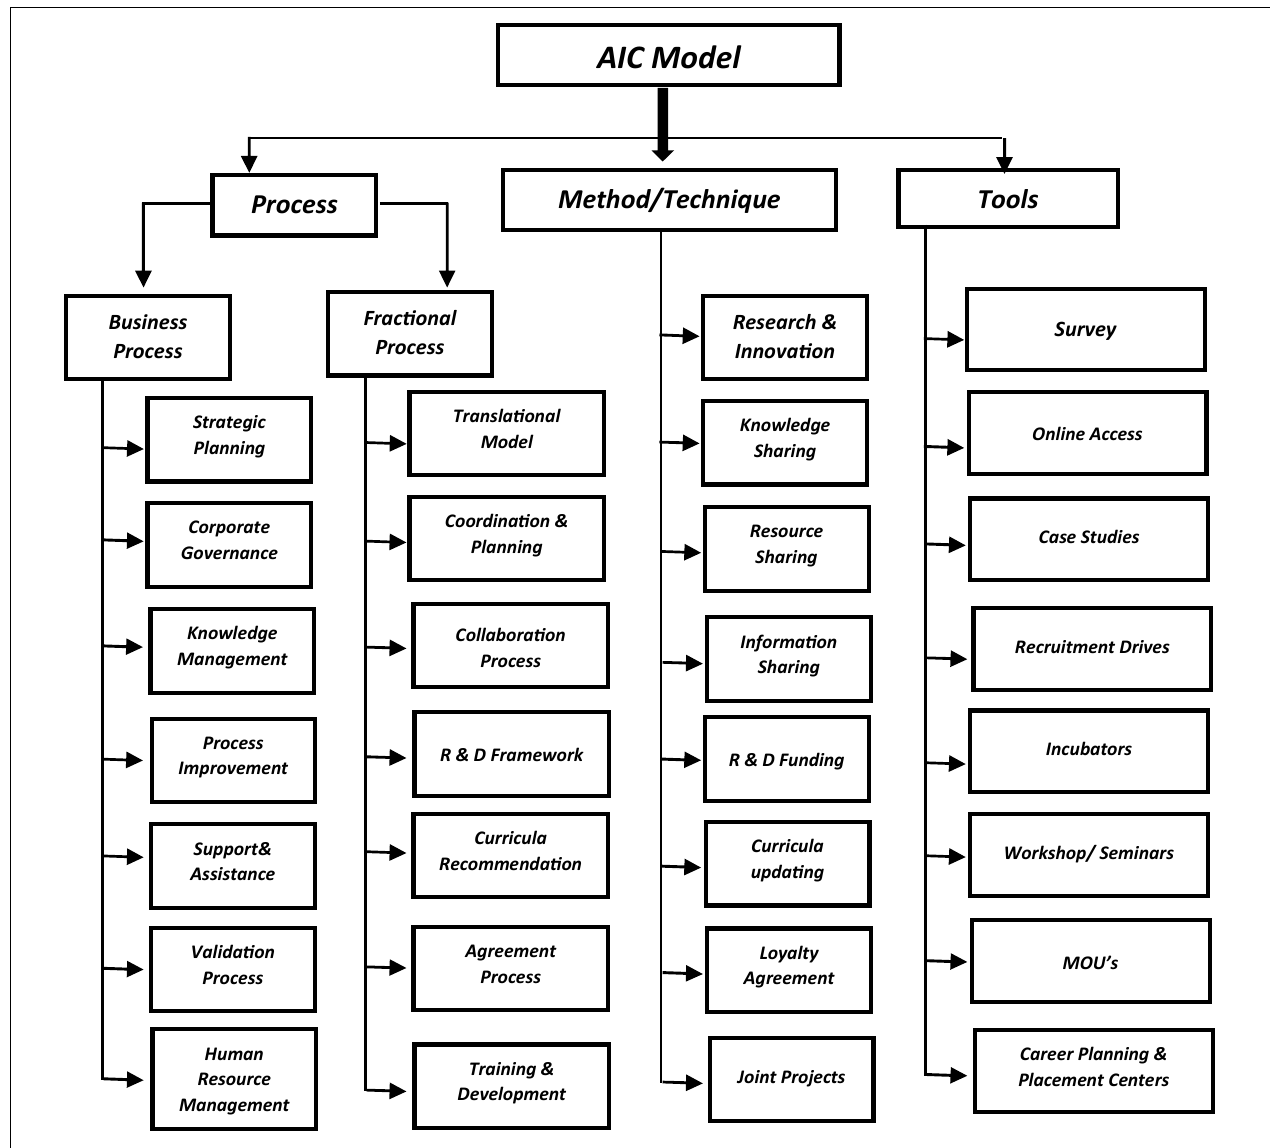
FIGURE 3 | Academia industry collaboration (AIC) design model-A concise plan to initiate and execute.